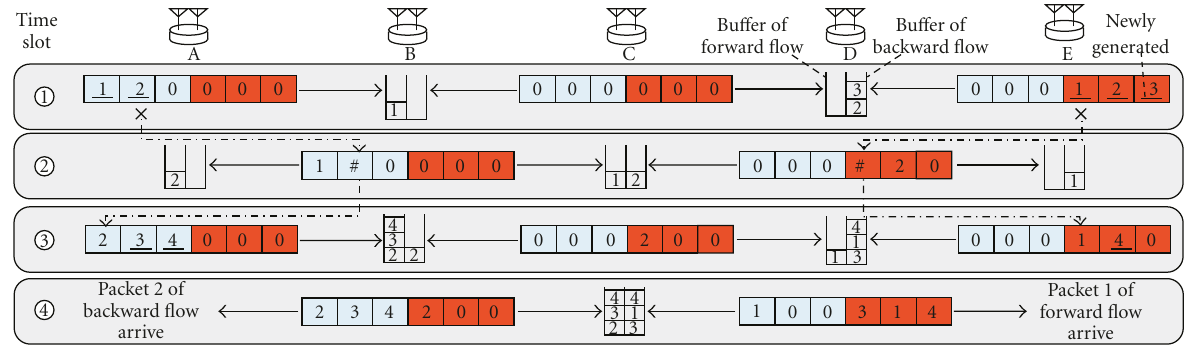
Figure 12: An example of the proposed retransmission scheme for MIMO network coding with L = 3.